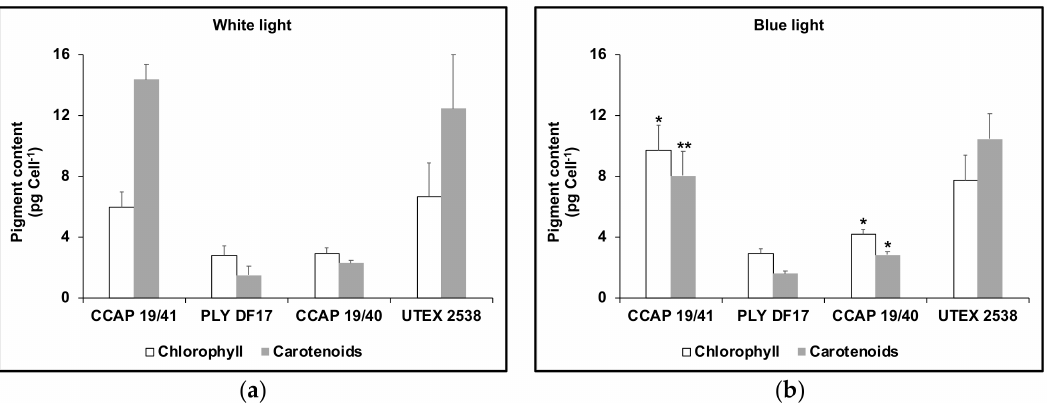
Figure 2. Cellular content of total carotenoids and of total chlorophyll for di ff erent D. salina strains cultivated each to the mid log phase under either white ( a ) or blue ( b ) light with a total light intensity of 1000 µ mol photons m − 2 s − 1 after dark-acclimation. Each culture condition was set up at least in triplicate. Results were analysed by one way ANOVA comparing blue light to white light, **: 0.001 < p ≤ 0.01; *: 0.01 < p ≤ 0.05.